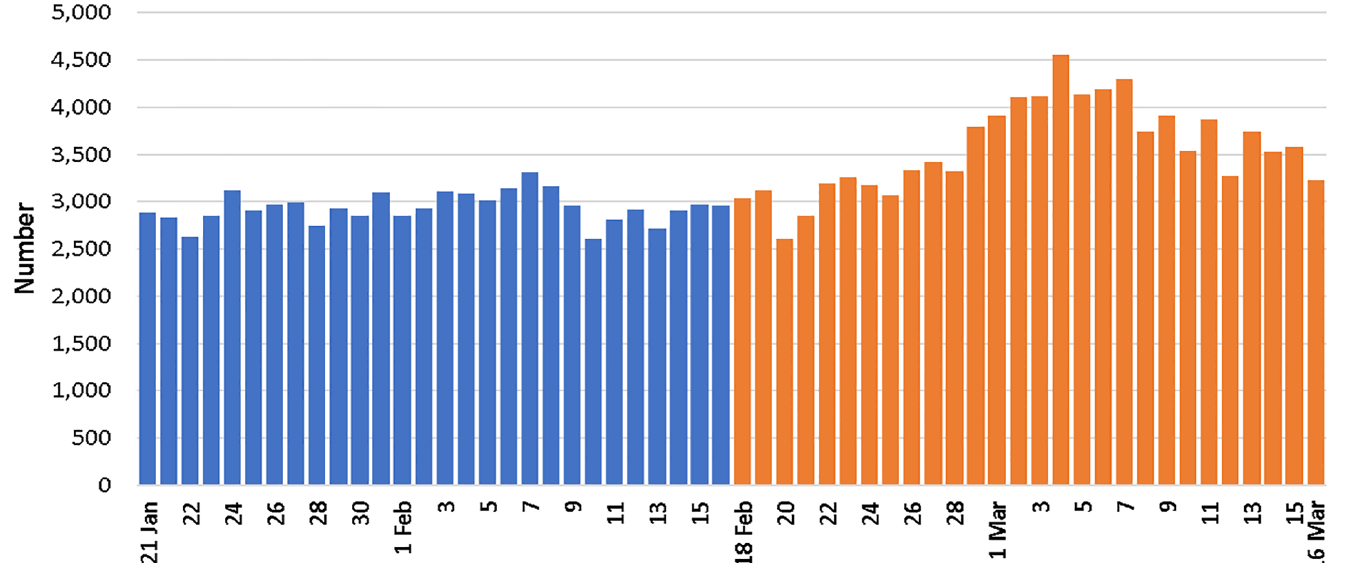
average of 12,687 EMS calls during the pre-outbreak period